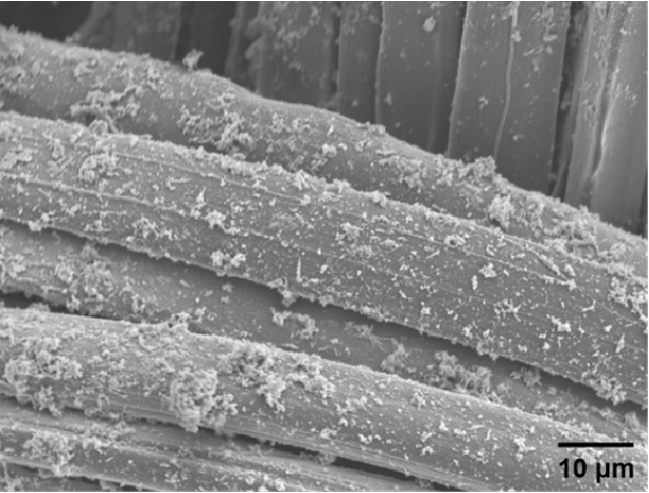
Figure 5. Scanning electron microscopy (S EM) image of the PANI SEA /silk composite prepared using seawater.